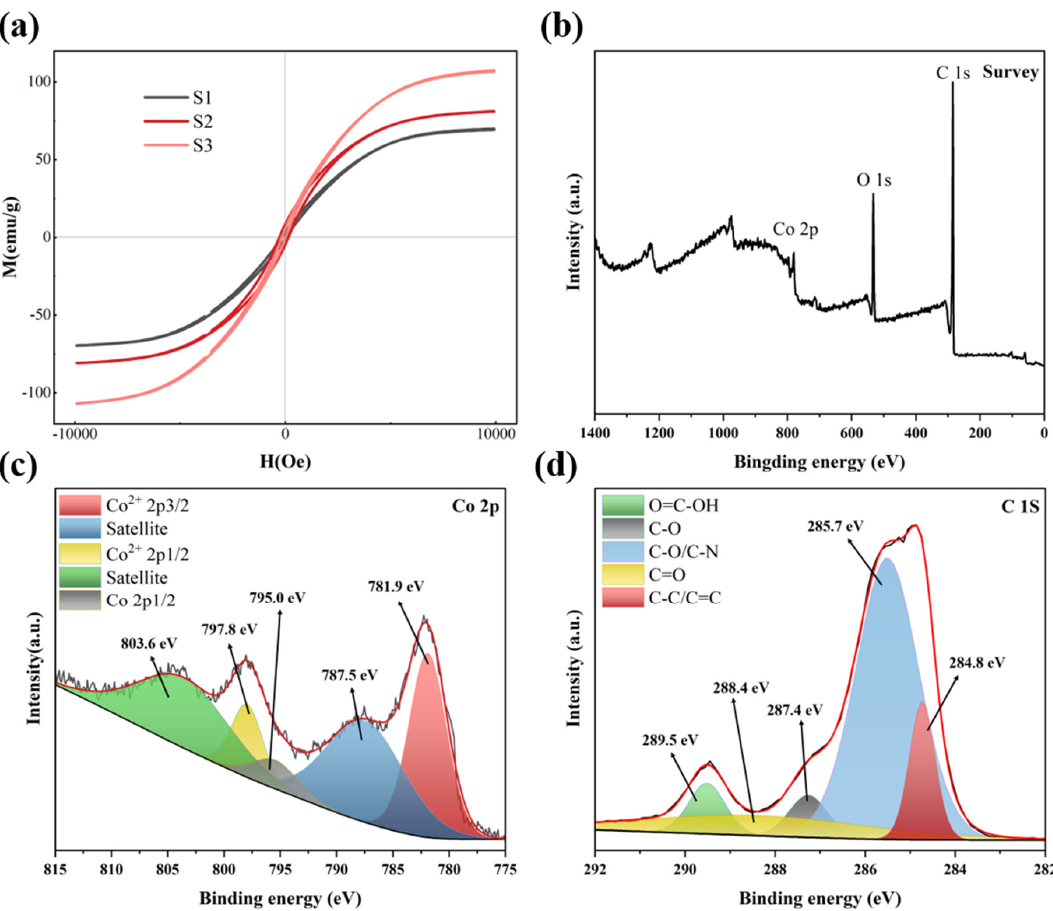
Figure 4. ( a ) Magnetic hysteresis loops of S1, S2 and S3, ( b ) XPS survey spectrum of S2, ( c ) high resolution Co 2p regions of S2, ( d ) high resolution C 1s regions of S2.